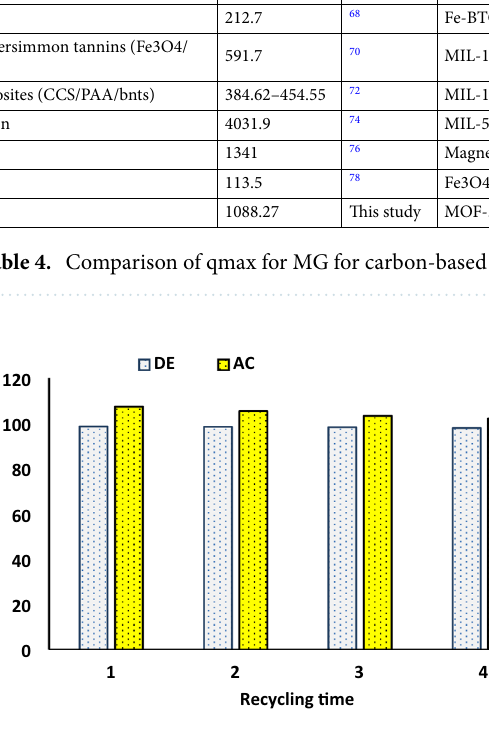
Figure 7. The illustration of desorption efficiency (DE) and adsorption capacity (× 10 −1 ) (AC) parameters under use/reuse cycles of